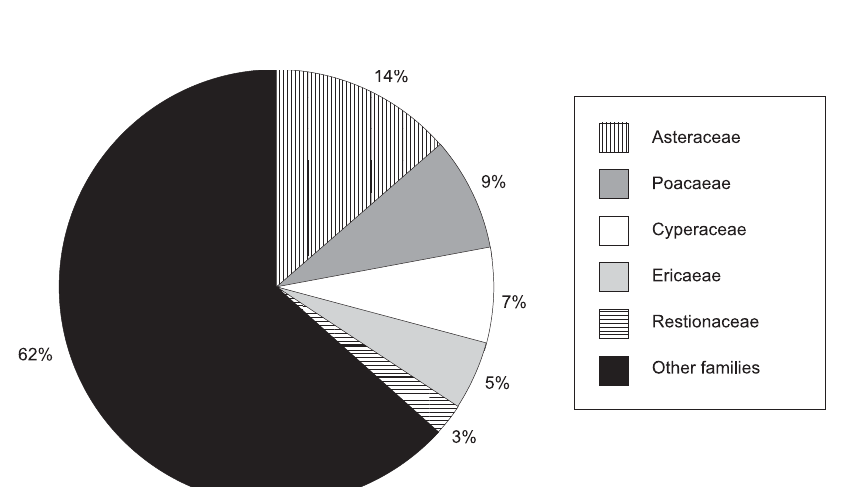
Fig. 4. Dominant plant families reflecting the percentage of total flora of springs on the Kam- manassie